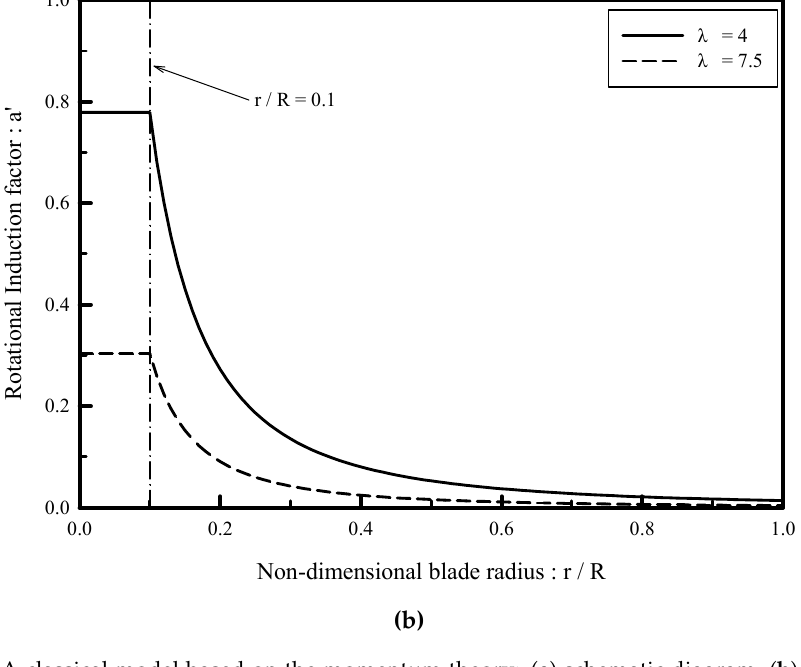
Figure 1. A classical model based on the momentum theory: ( a ) schematic diagram, ( b ) axial and rotational induction factors in the BEMT (blade element momentum theory) [1].